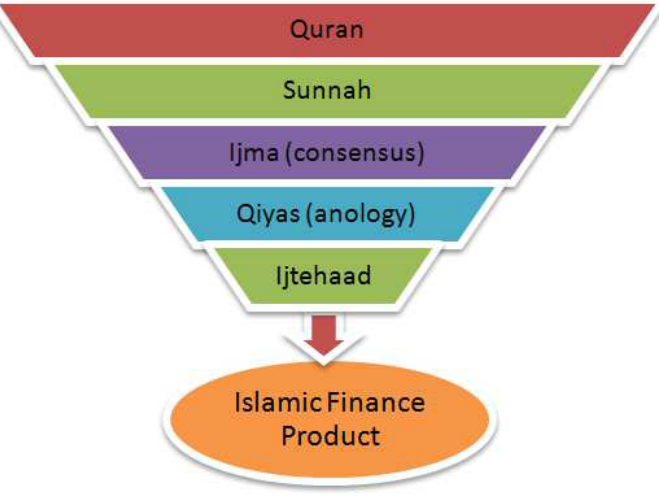
Fig. 2. Screening process of Islamic financial product